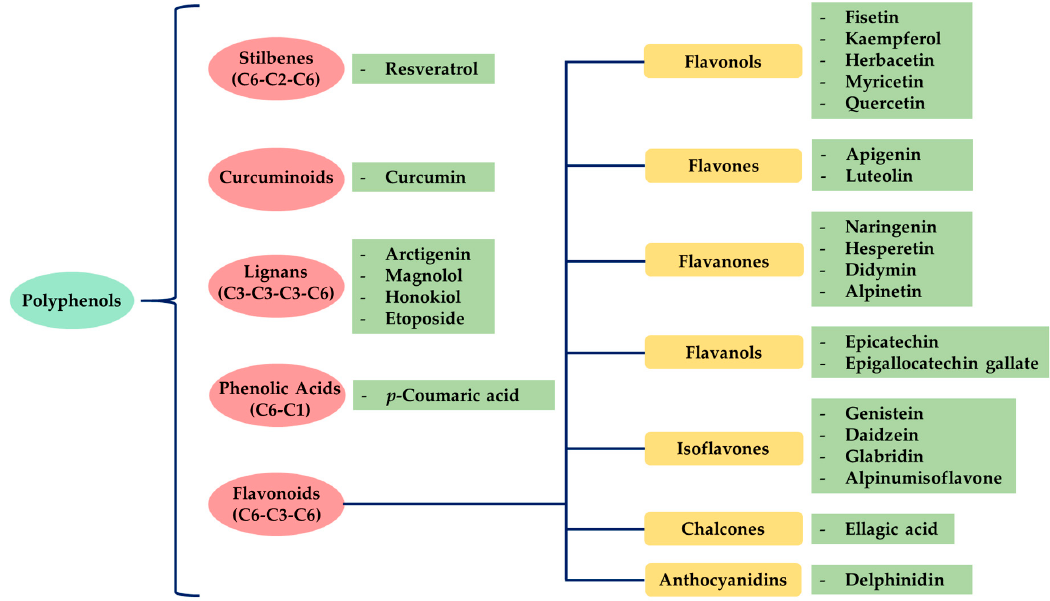
Figure 1. Classification of polyphenols and flavonoids. Examples of each subgroup with anticancer activity are mentioned.